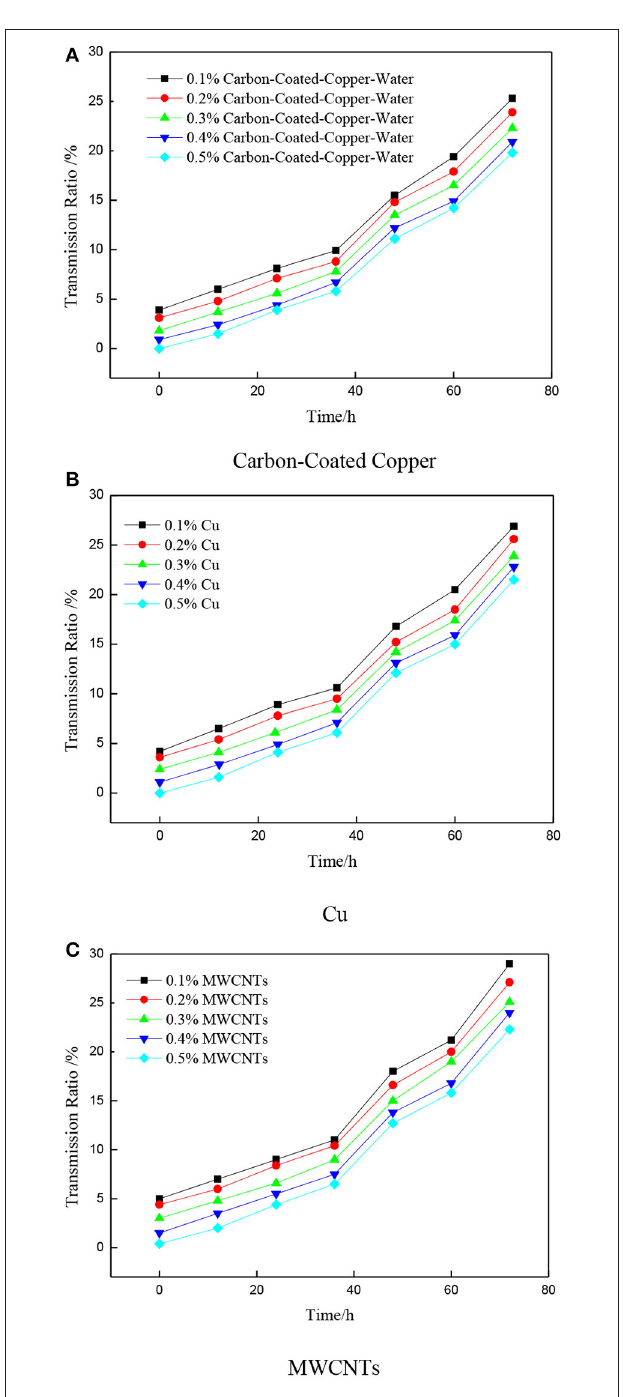
FIGURE 1 | Stability of the nanofluids. (A) Carbon-Coated Copper. (B) Cu. (C)